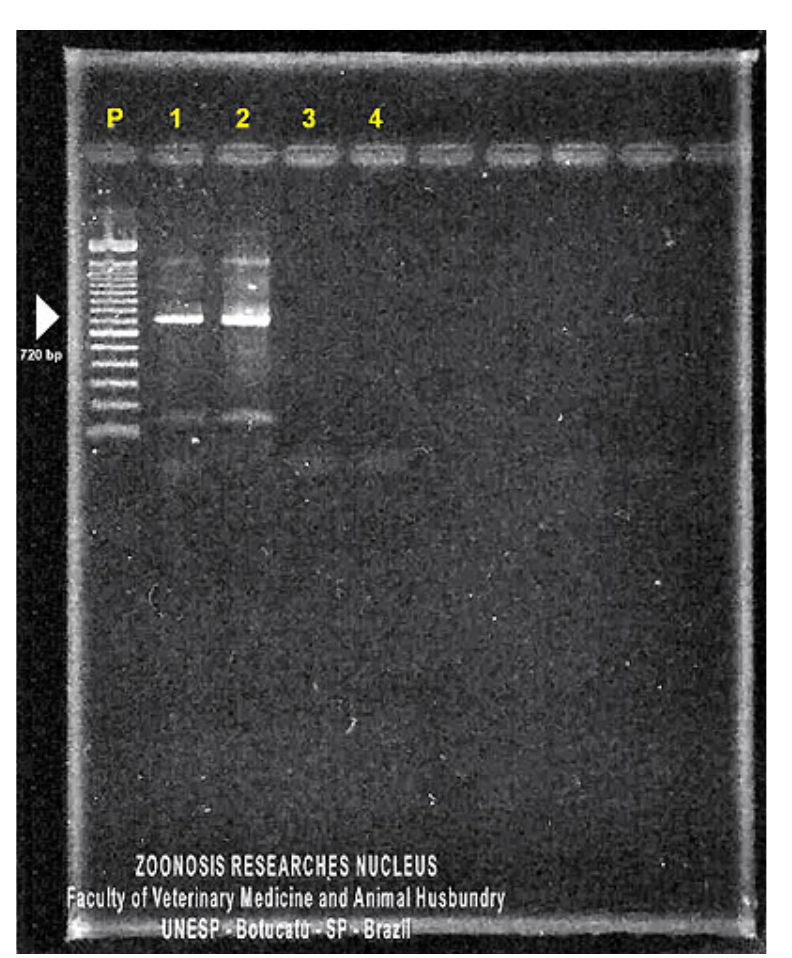
Figure 6: Result of the amplification of fragments of the KDNA minicircle of Leishmania sp by Polymerase Chain Reaction (PCR), obtained from the bone marrow aspirate culture. Electrophoresis on 1.5% agarose gel stained with ethidium bromide showing a 720bp fragment derived from minicircles of Leishmania sp. P: molecular weight standard 100bp (100bp DNA ladder - Invitrogen ® ); 1: positive control ( Leishmania chagasi strain); 2: positive sample for Leishmania sp; 3: extraction buffer (EB); 4: negative control